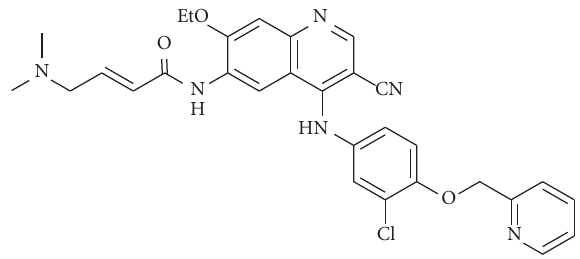
Figure 1: Structure of